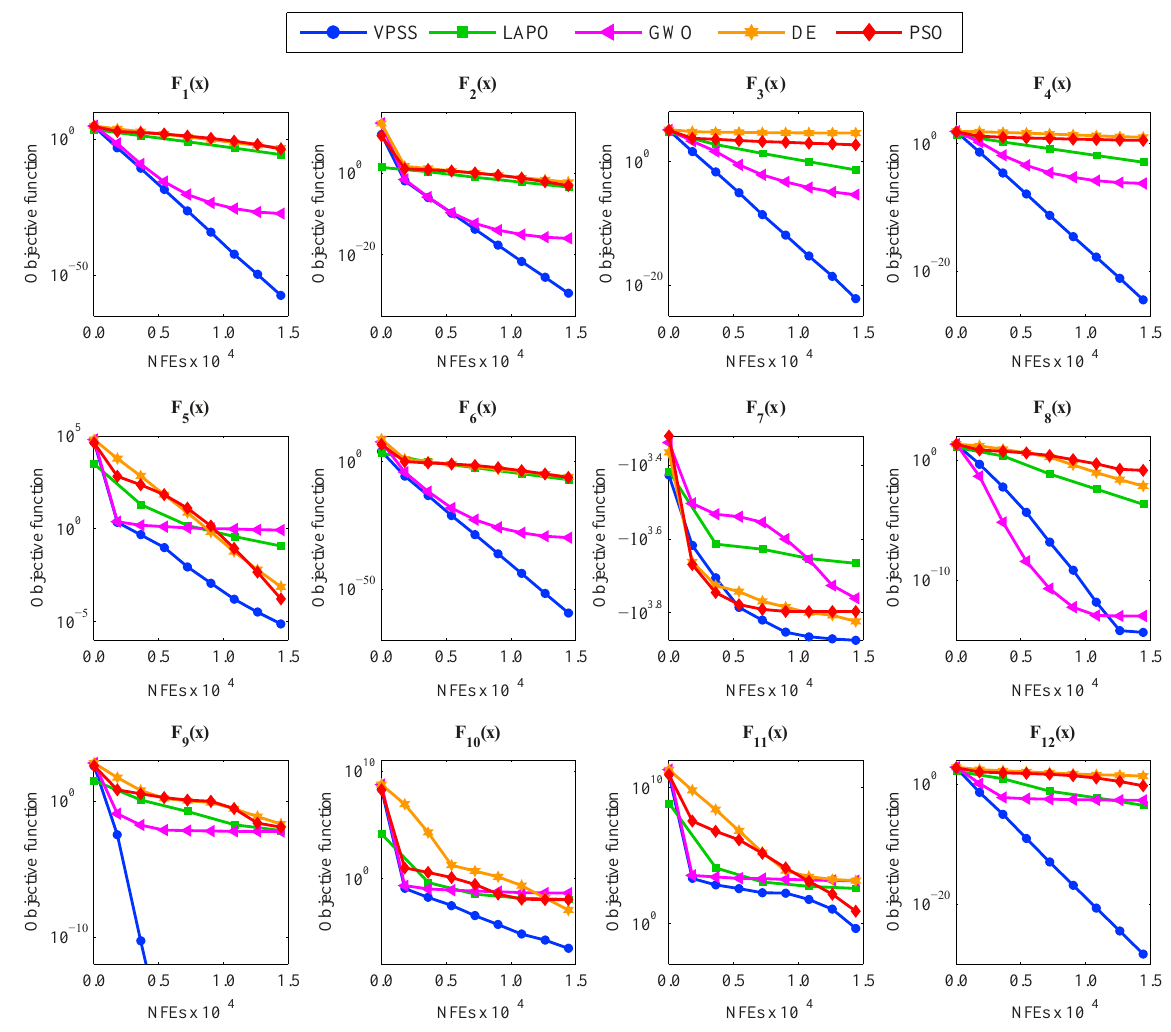
Figure 4. Convergence histories of average objective function values obtained by VPSS, LAPO, GWO, DE, and PSO versus the number of function evaluations (NFEs) for the mathematical benchmark functions.